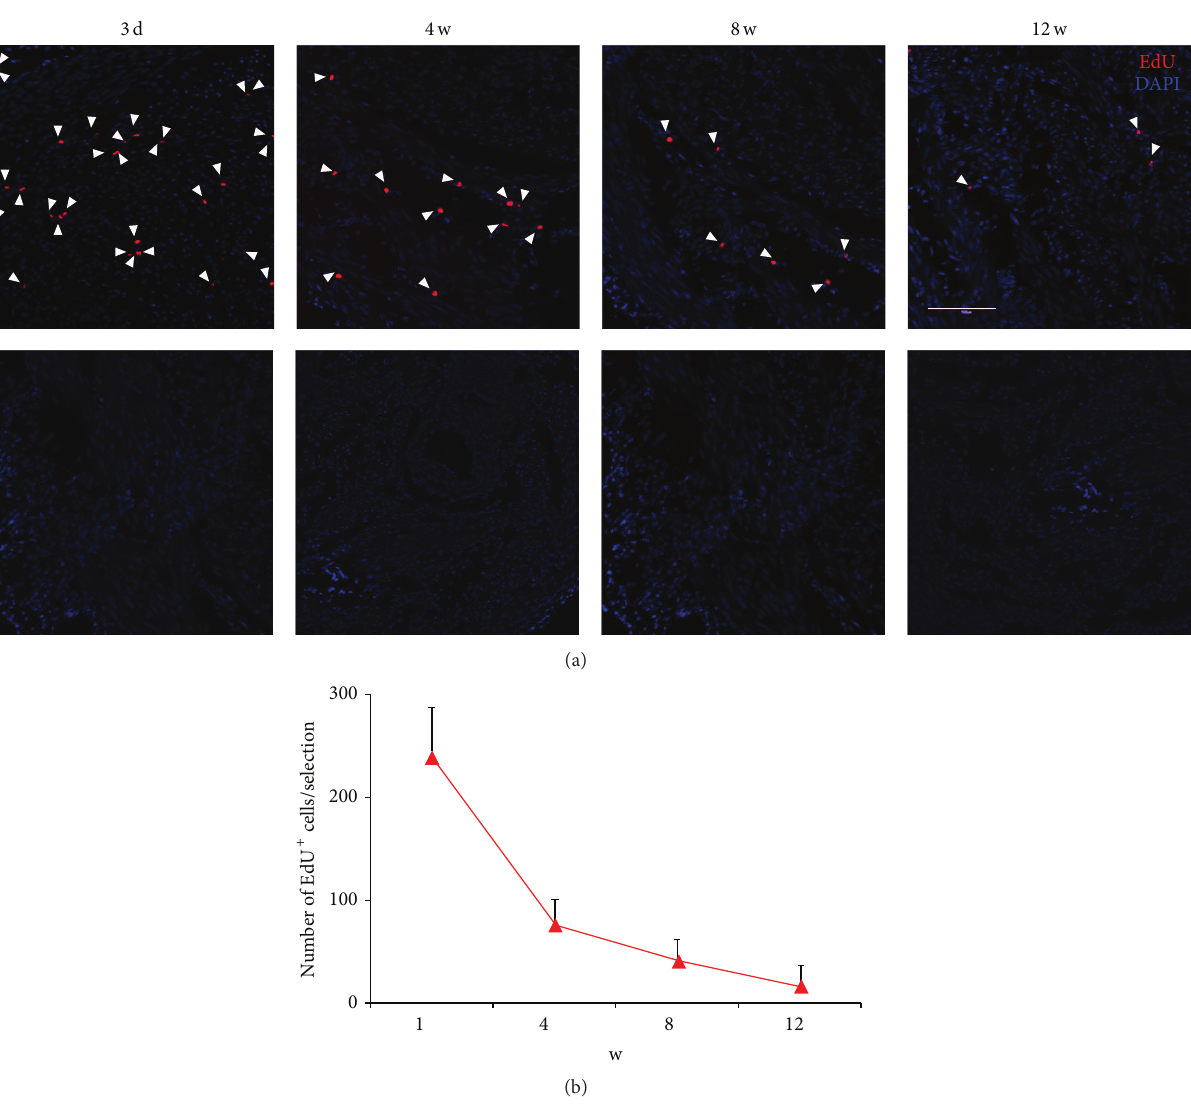
Figure 2: Tracking of injected AdMSCs in bladder tissue. (a) Up: representative images of EdU positive cells within the bladder wall at different time points after cell injection. The white bar indicates 200 𝜇 m. Bottom: results of the number of EdU positive cells within the bladder wall at different time points after cell